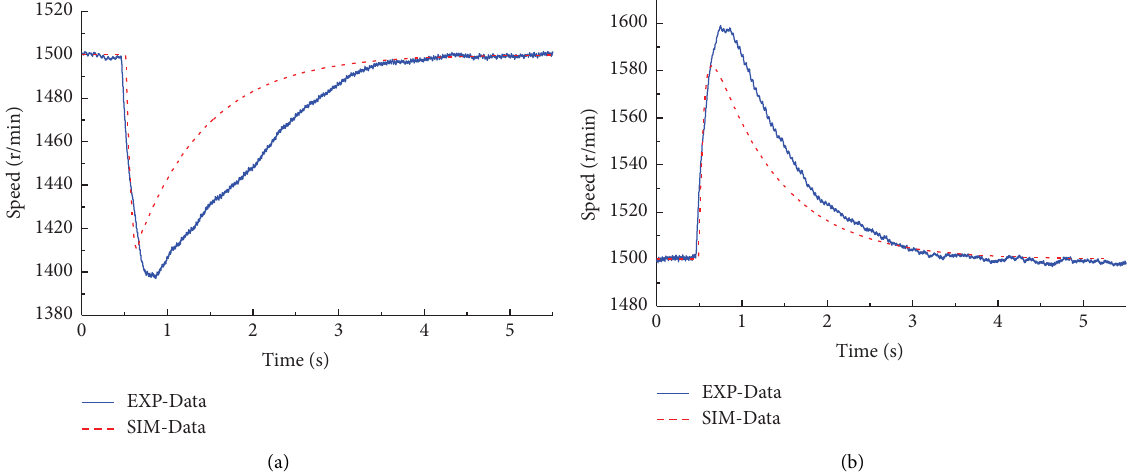
Figure 15: Simulation model verifcations during the sudden load and sudden unload processes. (a) Sudden load process. (b) Sudden unload process.